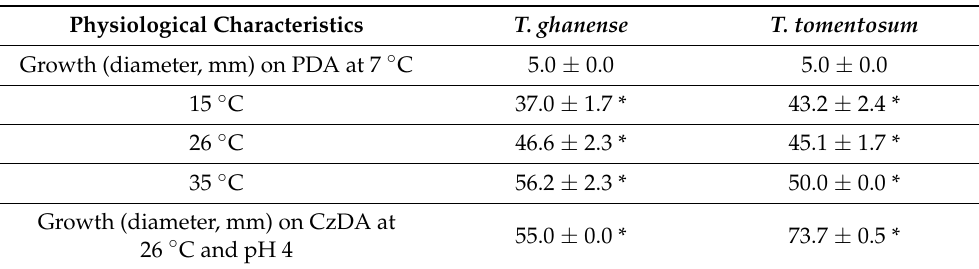
Table 4. Physiological characteristics of Trichoderma ghanense and T. tomentosum . * above the numbers indicate significant differences ( p < 0.05).